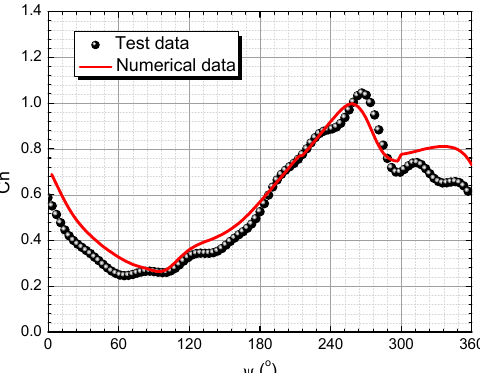
Figure 3. Comparison of numerical C n with test data of a SA349/2 rotor in forward flight.